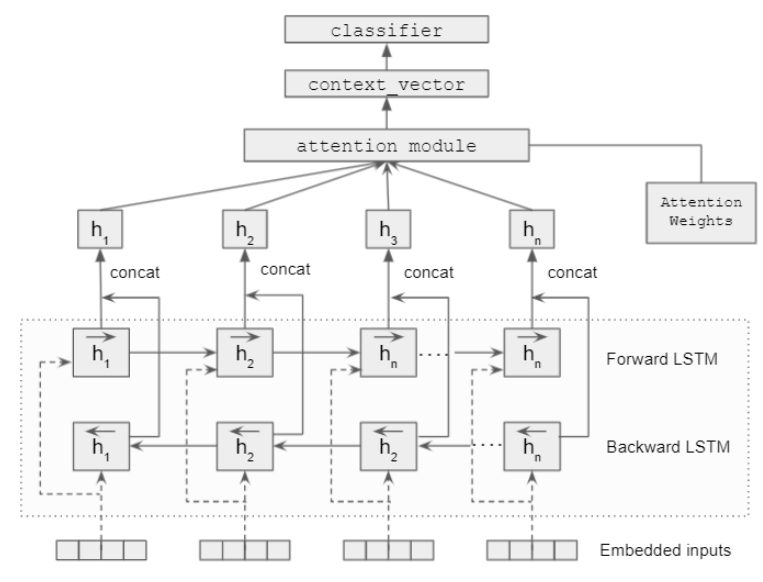
Figure 2. Bi-LSTM attention architecture